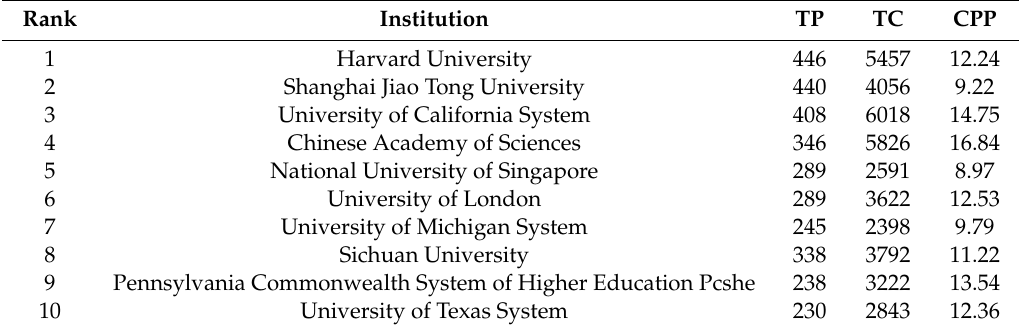
Table 5. The top productive and most cited institutions of topic set 1 for 1990 through